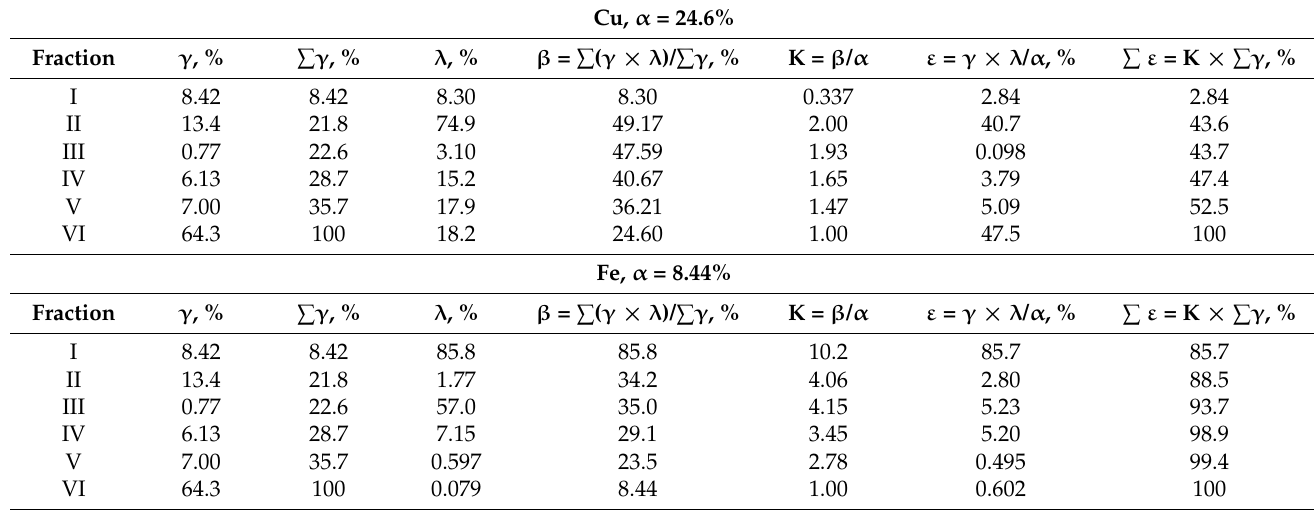
Table 10. The enrichment balance of the performed magnetic separation of copper, iron, neodymium, cobalt and